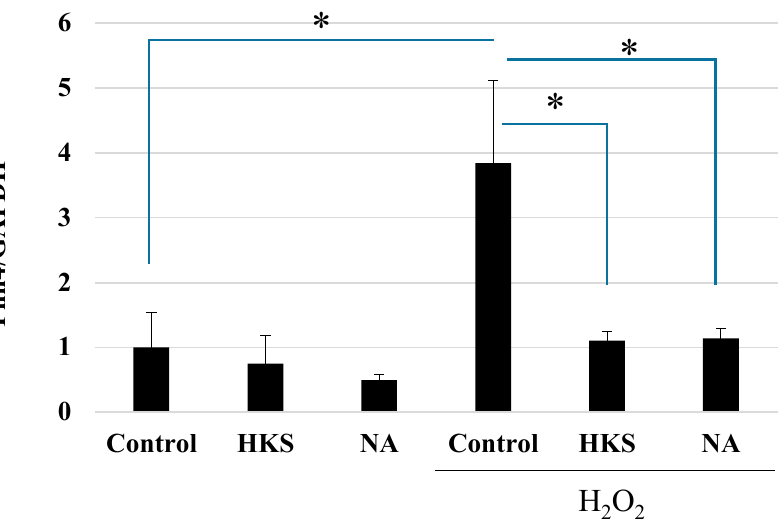
Figure 3. Bifidobacterium breve MCC1274 extracts and niacin protect SH-SY5Y cells against oxidative stress caused by exposure to H 2 O 2 . The SH-SY5Y cells were exposed to HKS ( B. breve MCC1274 heat-killed cell extracts, 1% v/v) or niacin (NA, 100 nM) with or without H 2 O 2 (200 µM) for 24 h. Human PLIN4 mRNA expression relative to human GAPDH expression was determined by RT-PCR. The data are shown as the mean + SD of four replicates. * p < 0.05 (Student’s t-test for two-group or non-repeated measures ANOVA with the Bonferroni post hoc test for multiple-group comparison, respectively).